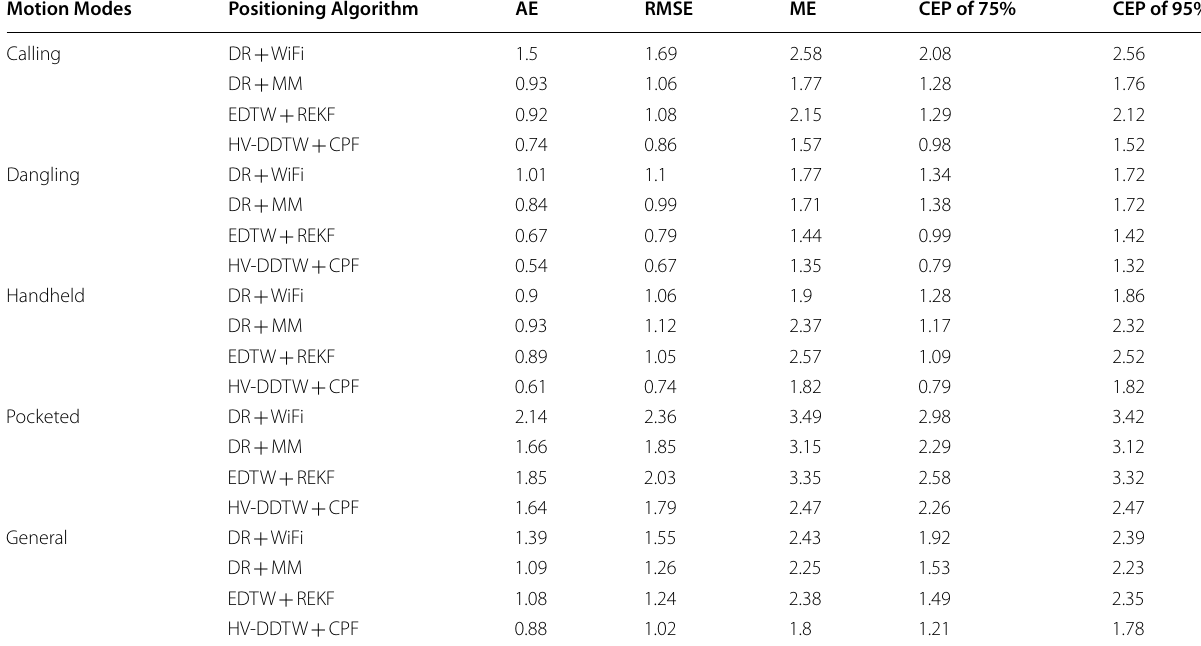
WiFi, DR MM, EDTW + +